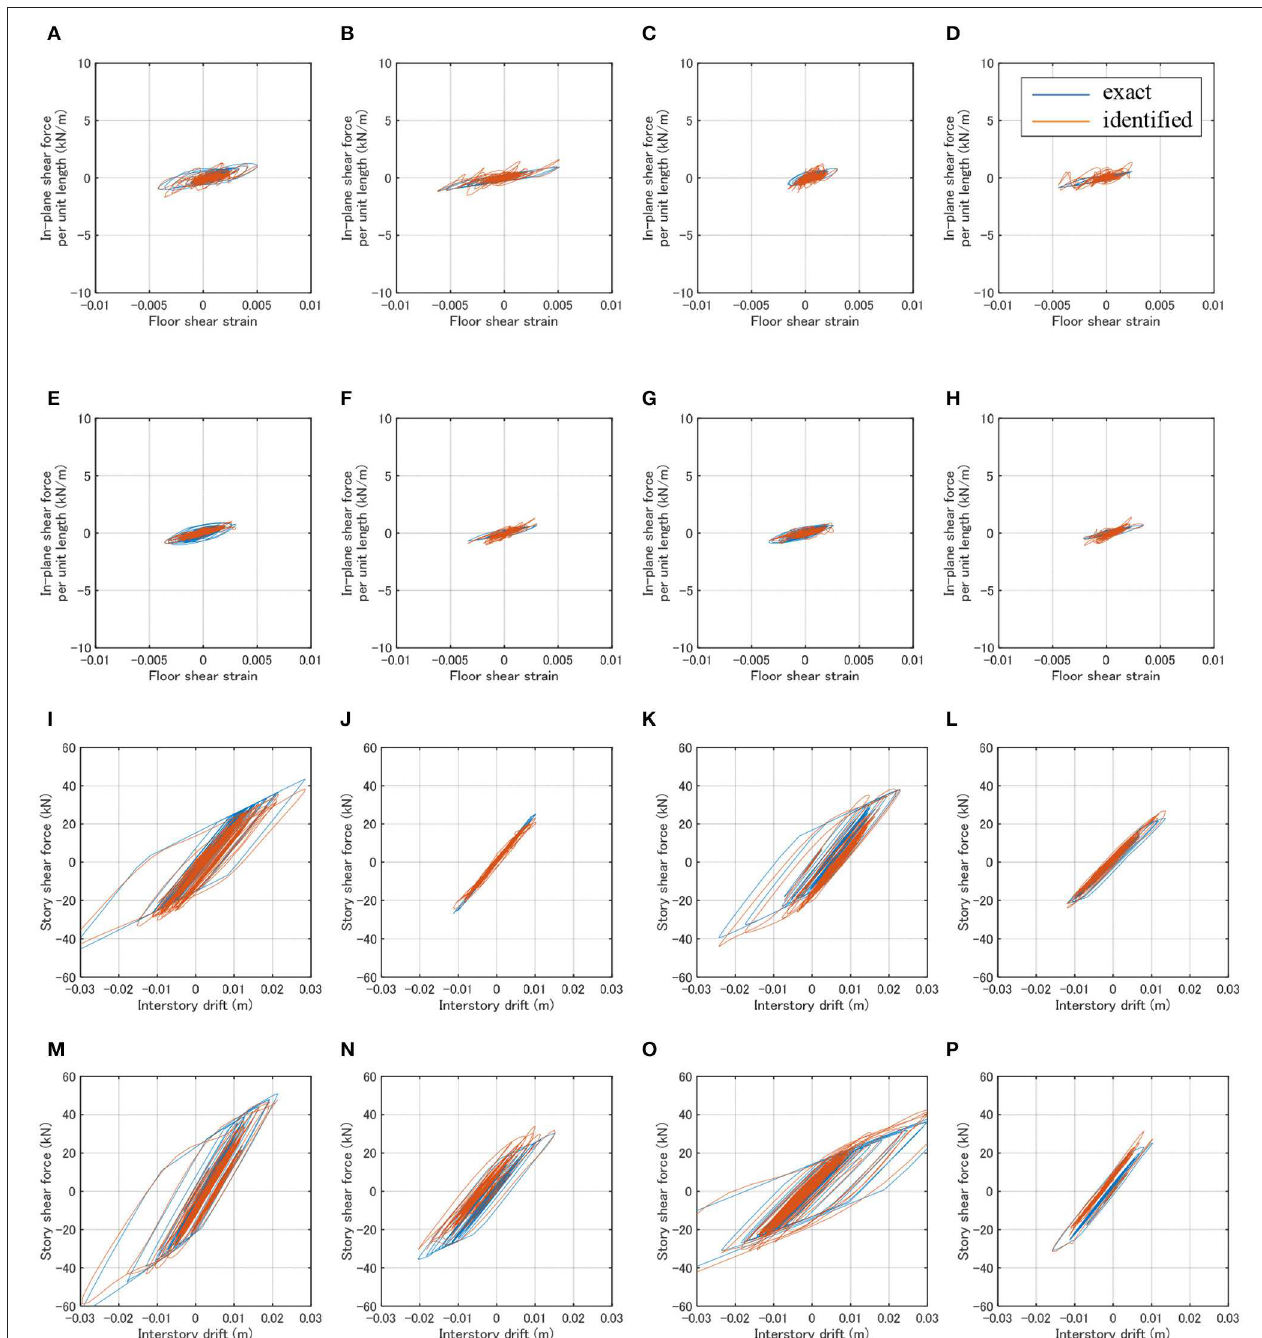
FIGURE 12 | Identification results for case of different yield strain for floor (El Centro 1940 NS). (A) H-frame (x1y1_1F). (B) H-frame (x1y2_1F). (C) H-frame (x2y1_1F). (D) H-frame (x2y2_1F). (E) H-frame (x1y1_2F). (F) H-frame (x1y2_2F). (G) H-frame (x2y1_2F). (H) H-frame (x2y2_2F). (I) V-frame (x1_1F). (J) V-frame (x1_2F). (K) V-frame (x3_1F). (L) V-frame (x3_2F). (M) V-frame (y1_1F). (N) V-frame (y1_2F). (O) V-frame (y3_1F). (P) V-frame